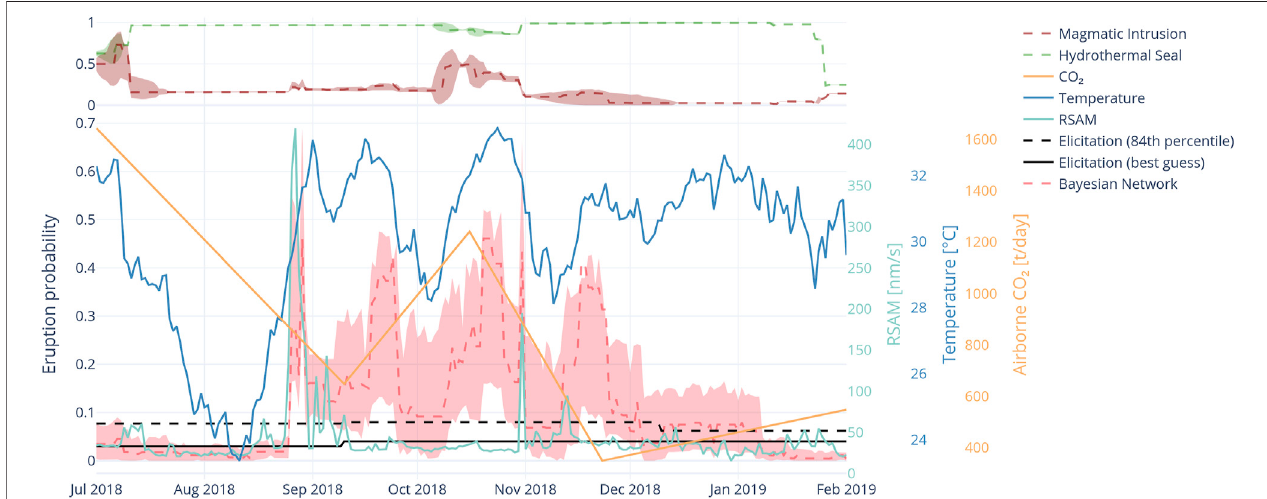
FIGURE 10 | BN forecast timeseries from August to February 2019 covering period of sustained high crater lake temperature. Pink shading indicates 90% con fi dence interval around the mean (red dashed line). Corresponding best guess and 84th percentile values from VMG elicitations shown in black curves. Lake temperature and RSAM are shown by blue and green curves respectively. The top panel indicates the values of the magmatic intrusion (red dashed line) and hydrothermal seal (green dashed line) with shading the 90% con fi dence interval.